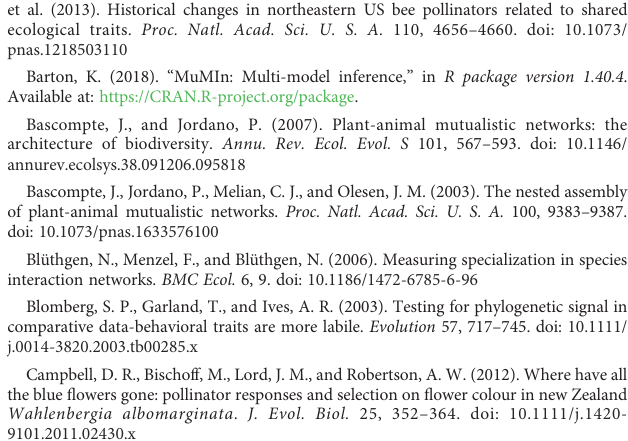
SUPPLEMENTARY FIGURE 6 Differences in fi ve fl oral traits ( fl oral size, fl ower density, fl oral shape, fl oral symmetry and fl oral color) among peripheral species, connect species and network hubs in the plant-pollinator network, which were performed a Tukey post hoc test by the package ‘ multcomp ’ in R . * P < 0.05, ** P < 0.01, *** P <